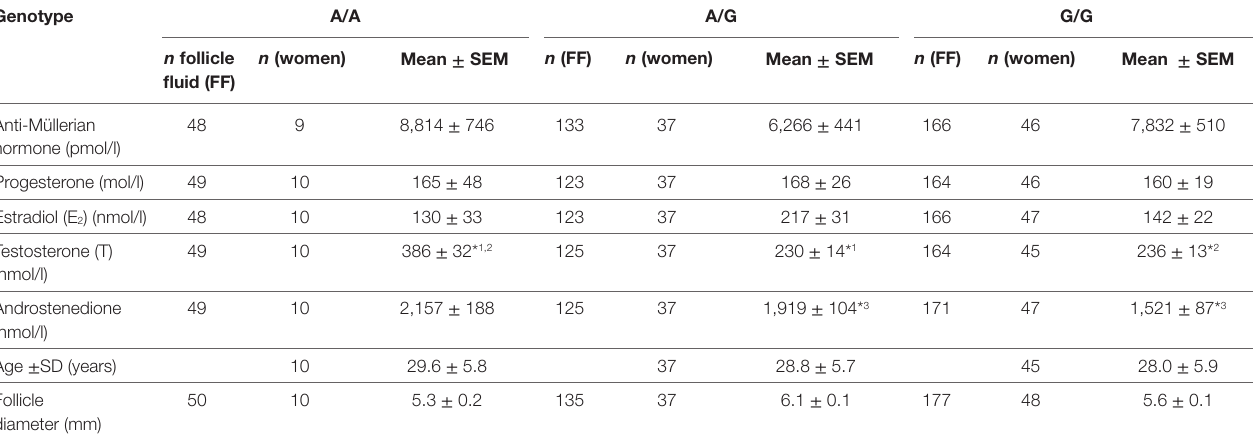
Table 1 | Intrafollicular hormone levels grouped according to follicle-stimulating hormone receptor − 29G > A genotype mean ± SEM. genotype